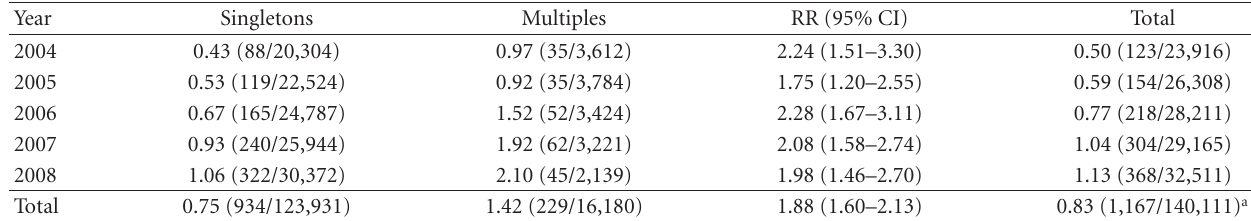
Table 2: Crude percentage of birth defects in ART pregnancy according to plurality.